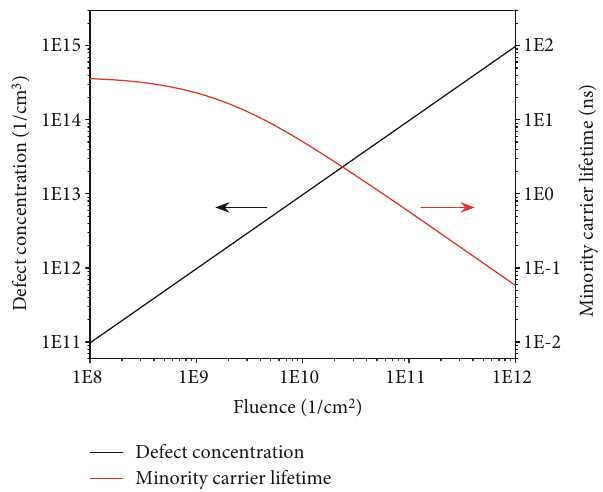
Figure 6: The defect concentration and minority carrier lifetime vs. 150keV proton fl uence.